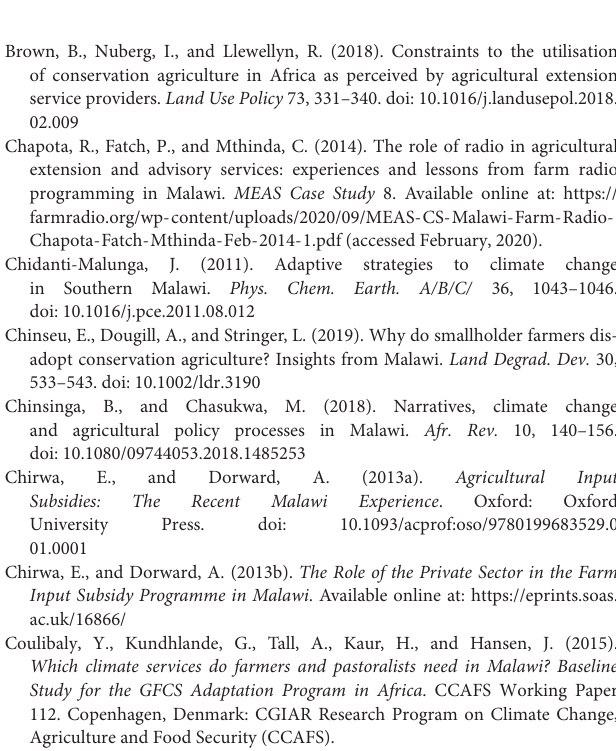
Supplementary Figure 1 | Wealth comparison between men and women (Household survey 2016, n = 201). Y axis- number of people. Statistically women are more likely to be poorer than men [Fisher’s exact test ( p > 0.005)]. Supplementary Table 1 | Yield comparison between crops cultivated under CA and non-CA in 2015/16 (Household survey, 2016). Supplementary Table 2 | Alternative incomes (Household survey, 2016). Supplementary Material A | The Household